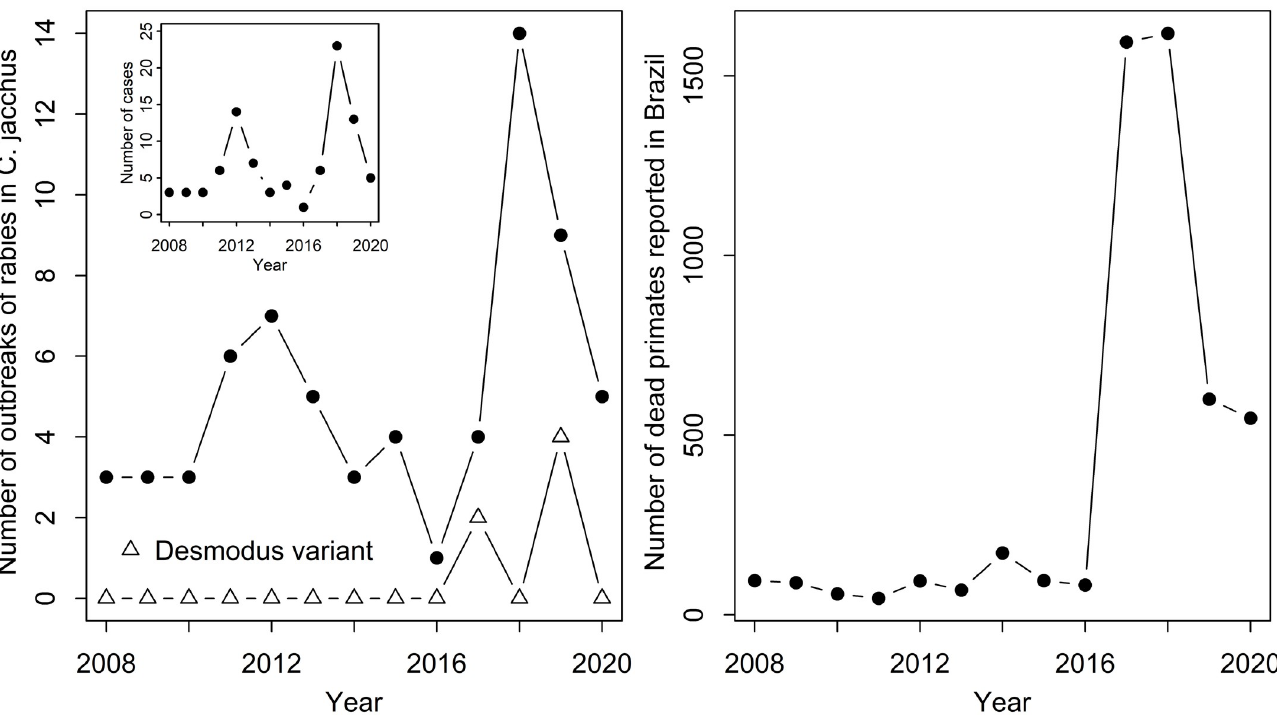
Fig 1. Number of outbreaks of rabies in Callithrix jacchus and overall dead non-human primate reported to the Brazilian Ministry of Health between 2008 and 2020. (Left) Total number of rabies outbreaks in C . jacchus . Open triangles show outbreaks belonging to the Desmodus rotundus variant (AgV3). The inset figure shows the total number of cases, defined as the total positive individuals reported within an outbreak. (Right) Total number of dead non-human primates reported to the Ministry of Health. Data of 2020 includes January to October.